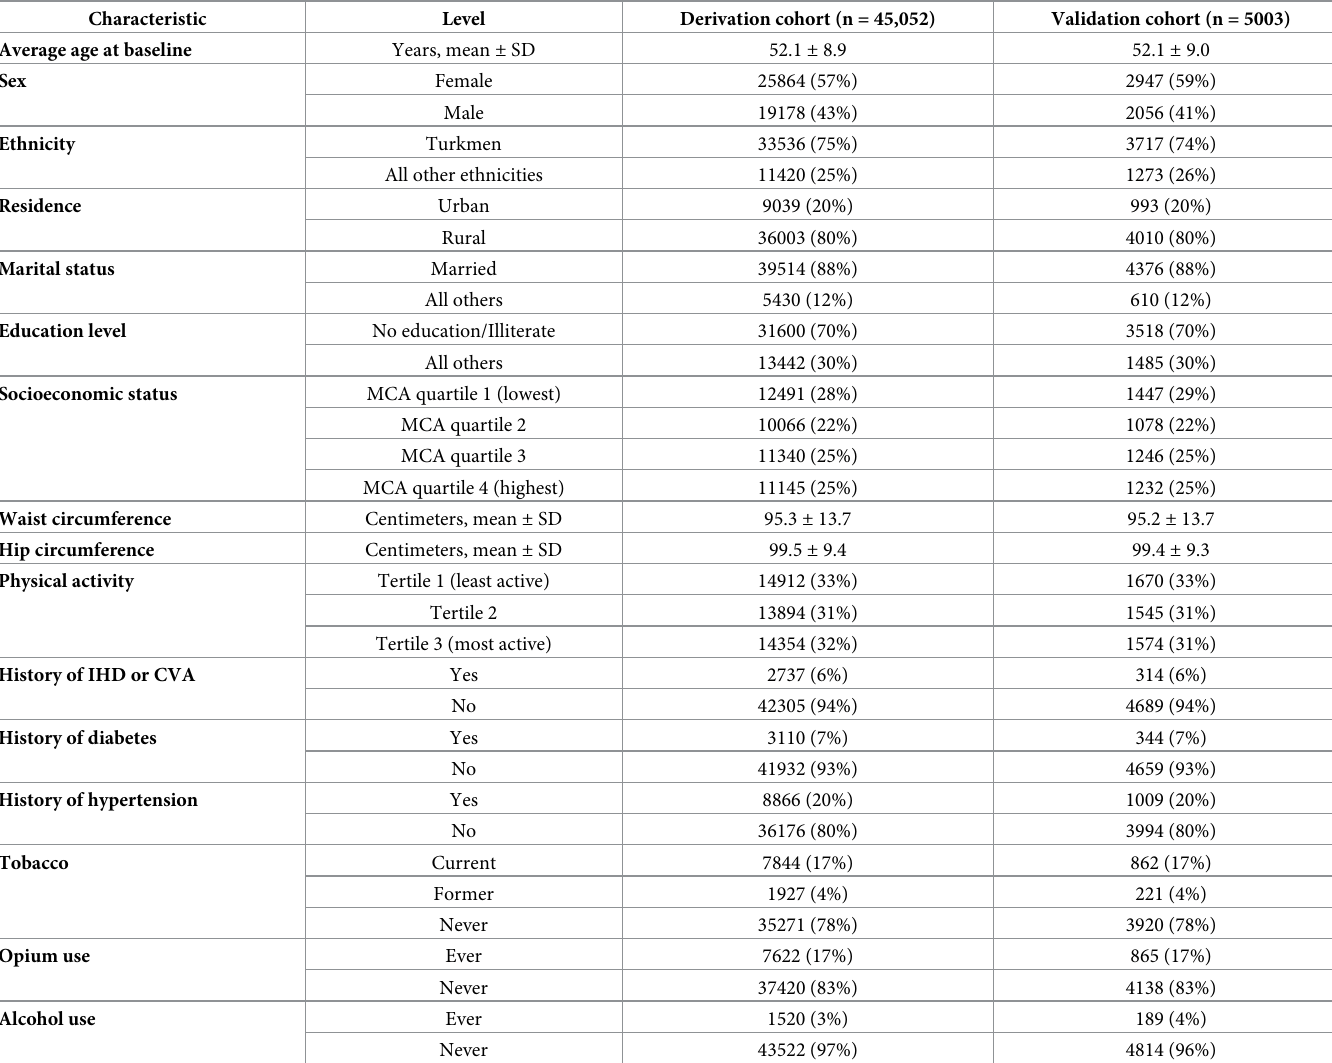
Table 1. Individual